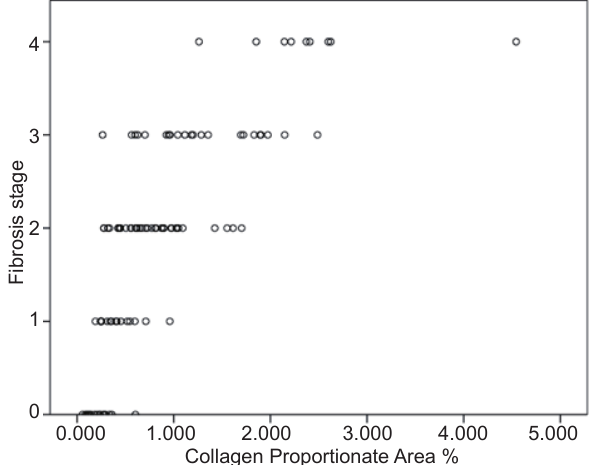
Figure 6 Scatter plot demonstrate the correlation between collagen proportionate area (CPA) and traditional fibrosis stages ( r = 0.819, P <